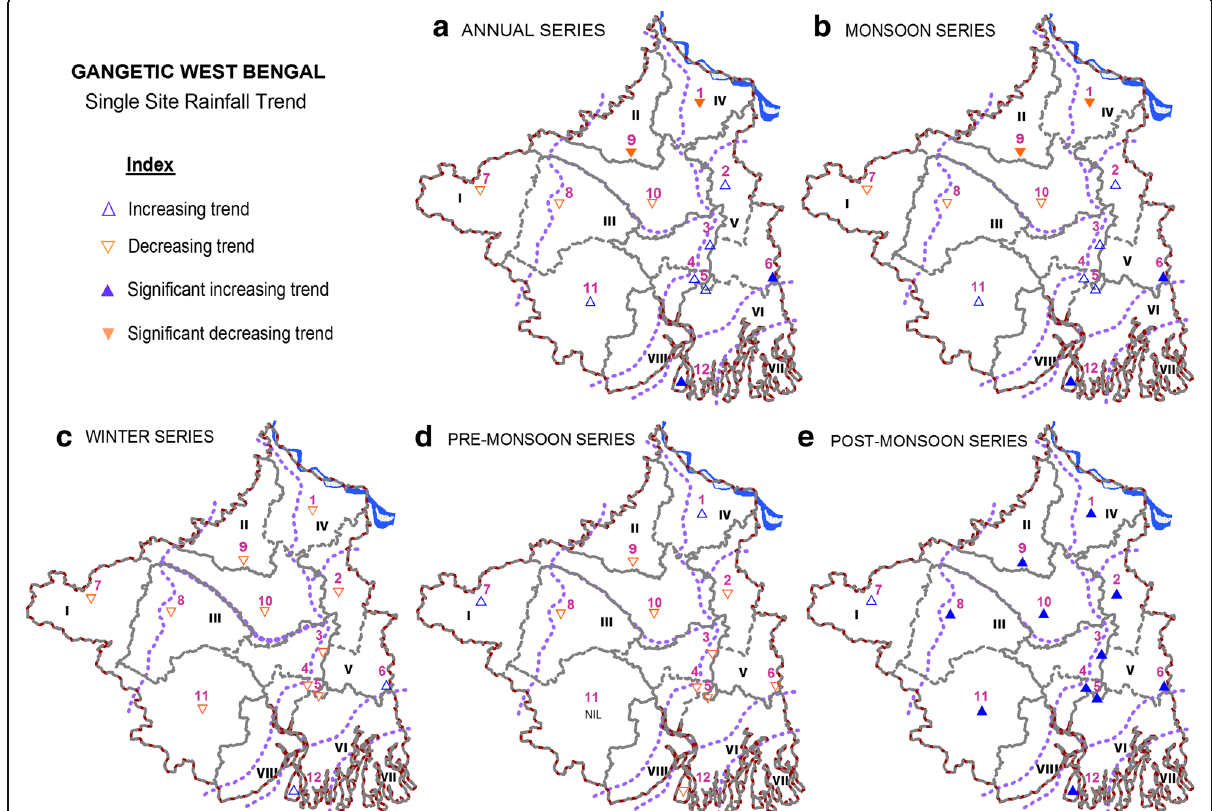
Fig. 2 Site specific trend for ( a ) annual ( b ) monsoon ( c ) winter ( d ) pre-monsoon and ( e ) post-monsoon rainfall during